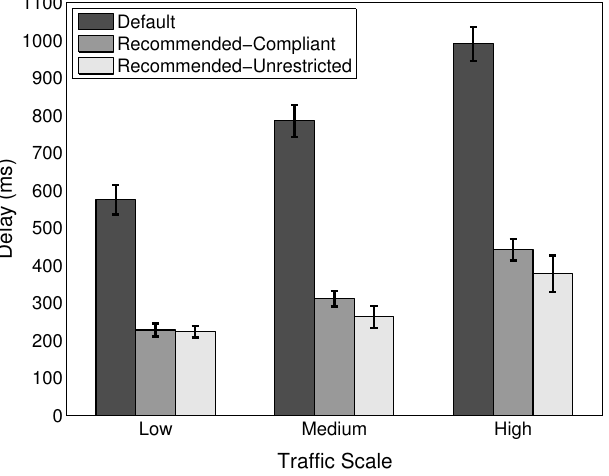
Figure 21. Comparison of average delays between default, Recommended-Compliant and Recommended-Unrestricted stack configurations, including 95% confidence